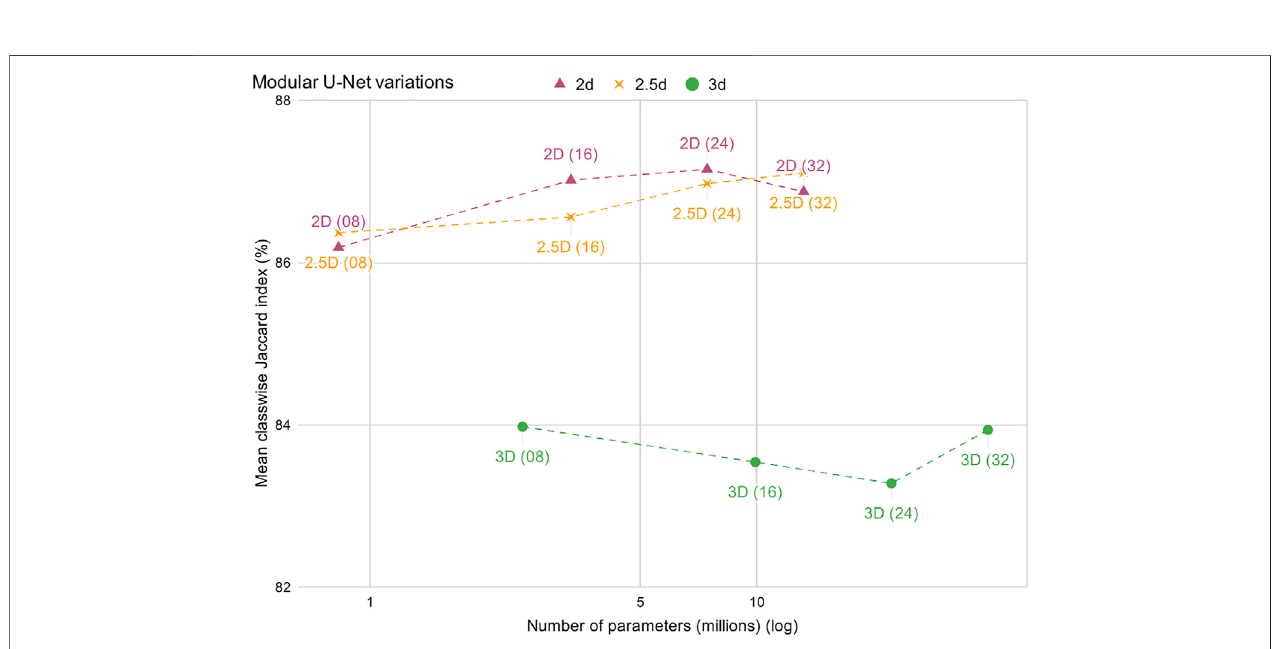
FIGURE8| ModularU-Netvariationscomparison.Onthe x -axis,thenumberofparameters;onthe y -axisthemeanclass-wiseJaccardindices.TheModularU-Net 2D, 2.5D, and 3D versions are scaled with f 0 (in parentheses), the number of fi lters of the fi rst convolution of the fi rst Convolutional Block.